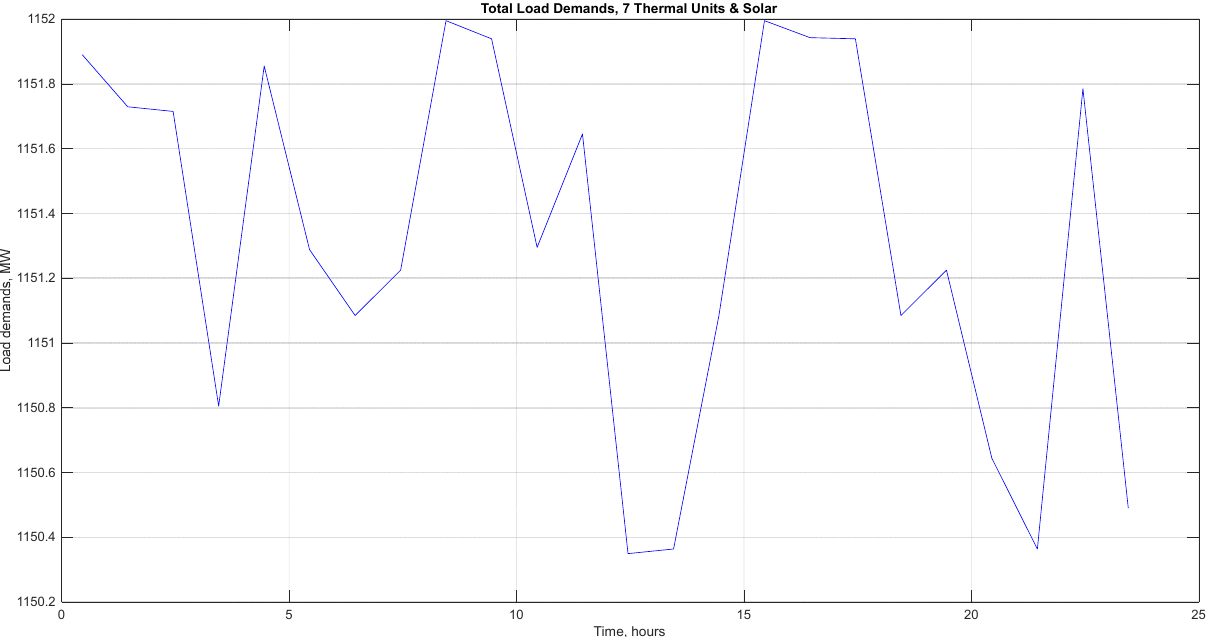
Figure 2. Estimated varying electrical load demands on a 24-h basis.